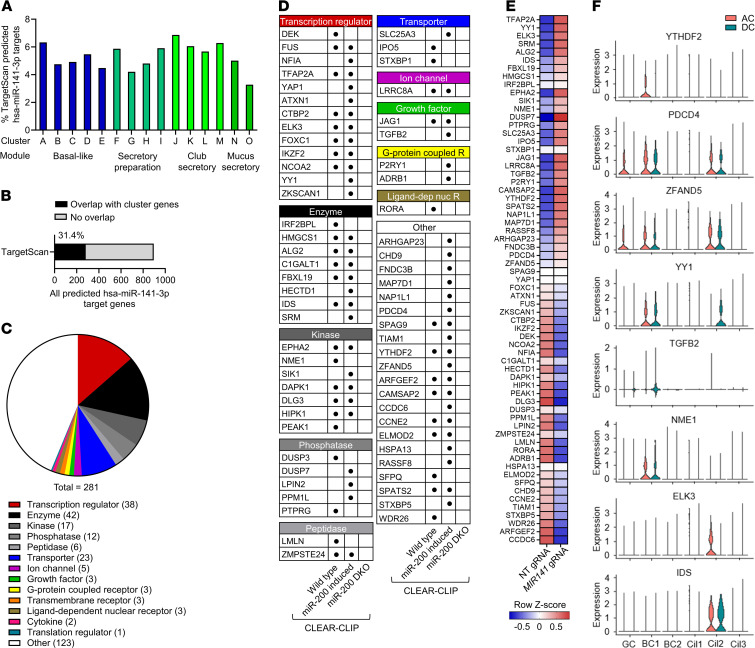
miR-141-3p targets a large number of genes expressed during the transition from basal cell to mucus secretory cell.(A) Percentage TargetScan predicted hsa-miR-141-3p targets in distinct clusters identified by pseudotime gene expression analysis of epithelial cell differentiation from basal-like presecretory cells into mucus secretory cells in human airways. Pseudotime gene expression analysis was published by Goldfarbmuren et al. (24). (B) Percent predicted targets in pseudotime gene clusters of all TargetScan-predicted hsa-miR-141-3p targets. (C) Type of protein encoded by 281 TargetScan-predicted hsa-miR-141-3p gene targets found in pseudotime clusters. (D) Sixty-five TargetScan-predicted miR-141-3p gene targets found in pseudotime clusters and identified by differential CLEAR-CLIP analysis of primary murine epithelial cells from WT, miR-200 family–induced, and miR-200 family–double deficient mice (n = 3/group) (26). (E) Expression by RNA sequencing of 65 miR-141-3p target genes in HBECs that have undergone gene editing with NT or MIR141 gRNAs, subsequently grown at ALI with IL-13 stimulation (n = 4/group). (F) Gene expression, as assessed by single cell RNA sequencing, of bronchial epithelial brushings obtained from allergic asthmatic subjects 24 hours after segmental allergen challenge (n = 4) or diluent control (n = 4).